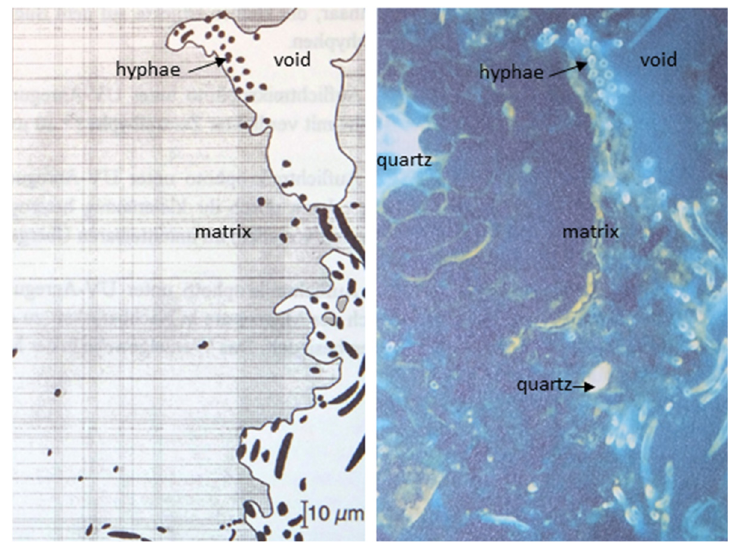
Figure 5. Evaluation of the soil preparations embedded in polyester resin polished and stained with acridine orange. Left: results of the object identification with the picture analysis system Leitz CBA 8000 at display windows of ca. 250 µ m edge length. Hyphae and root fragments (black), soil matrix (grey-shaded) soil pores and voids (white). Right: micro-photo of the same display window reflecting light with UV activation (according to Reference